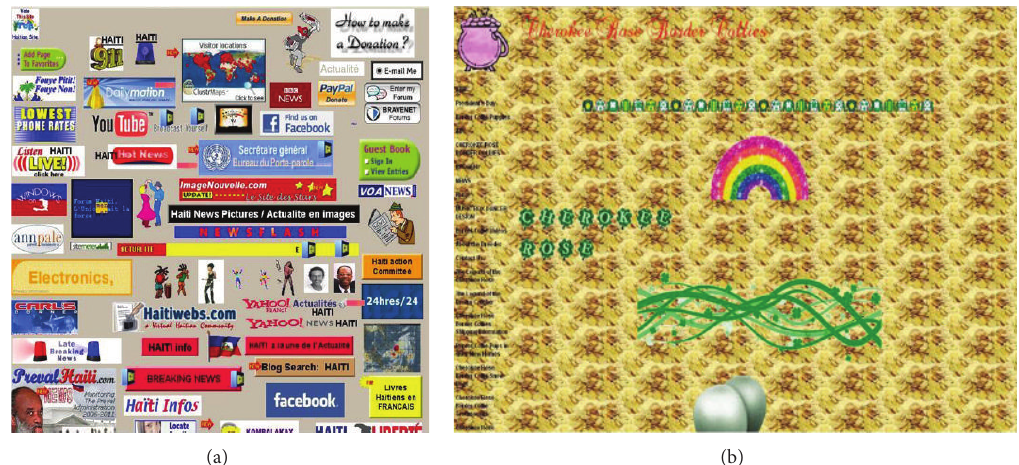
Figure 1: Examples of web page design problems. It is not clear if the user will get to see the worthwhile information at all in either of the